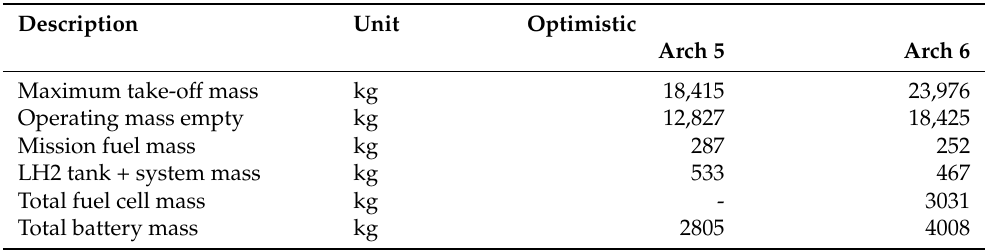
Table 12. Results on the essential masses from the initial sizing for Architecture 5 (LH2-Turboprop) and 6 (LH2-Fuel cell). As Architecture 6 did not converge in the conservative scenario, a comparison can only be shown for the optimistic